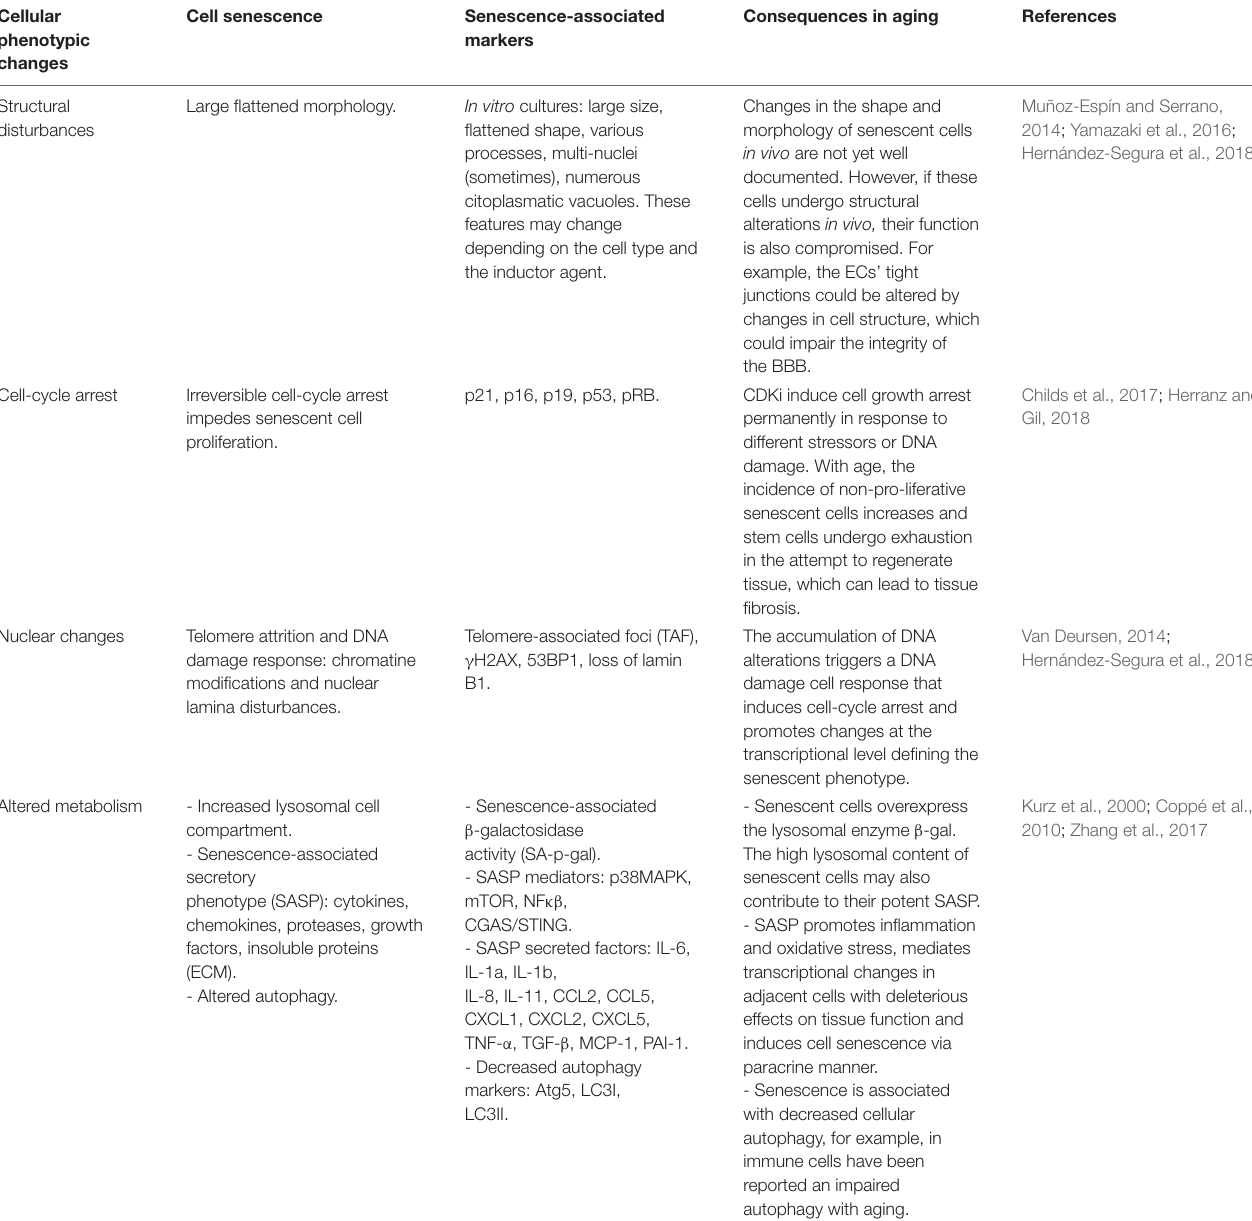
TABLE 1 | Compilation of the main phenotypic features of senescent cells and consequences of their age-related accumulation. Cellular phenotypic